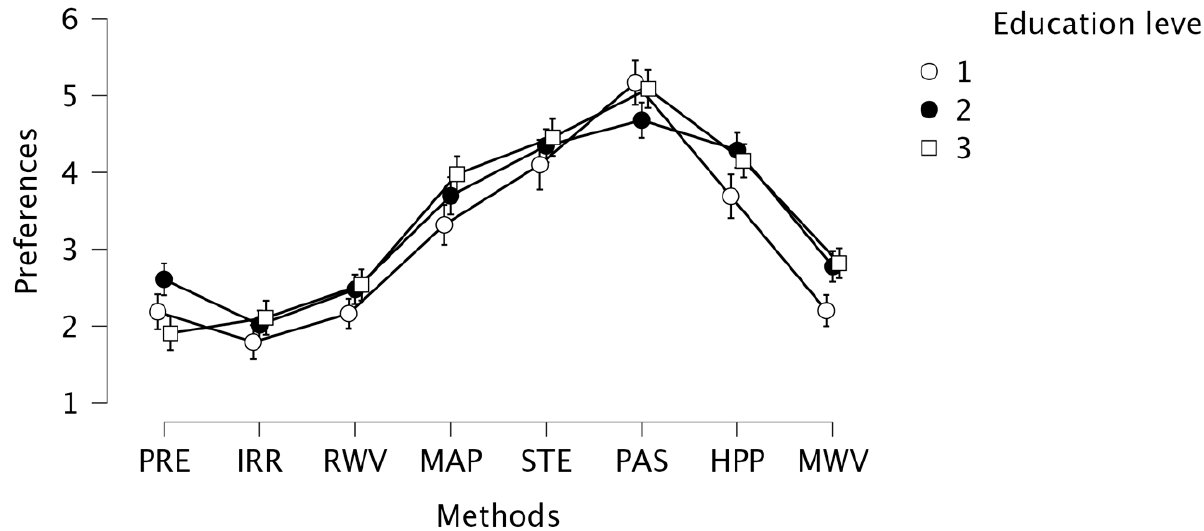
Figure 2. Consumer preference for food product preservation methods depending on education level; 1—lowest; 2—average; 3—highest (PRE—addition of preservatives; IRR—irradiation preser- vation; RWV—radio wave preservation; MAP—packaging in modified atmosphere preservation; STE—sterilisation; PAS—pasteurisation; HPP—high-pressure processing; MWV—microwave preservation).